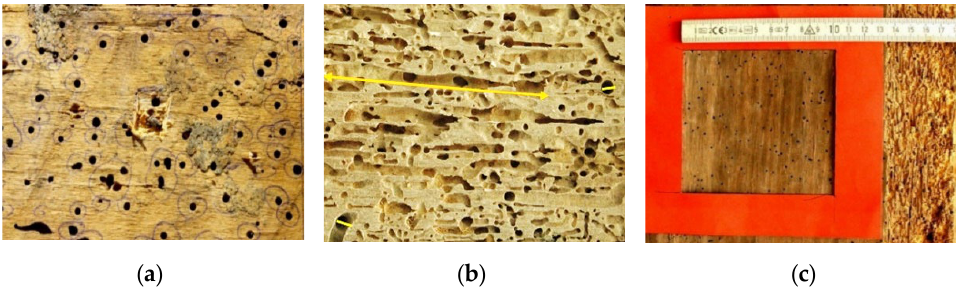
Figure 5. Insect holes and galleries: ( a ) at surface; ( b ) at interior; ( c ) comparative.